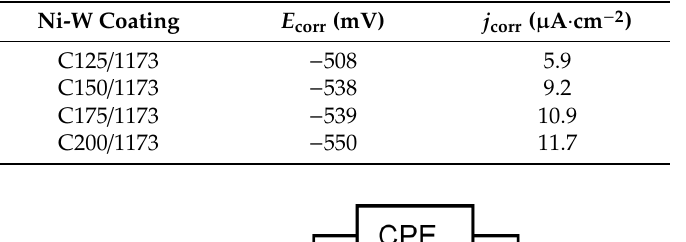
Table 2. Corrosion potential E corr and corrosion current density j corr determined for Ni-W coatings after heat treatment in the air, in dependence on deposition current density.